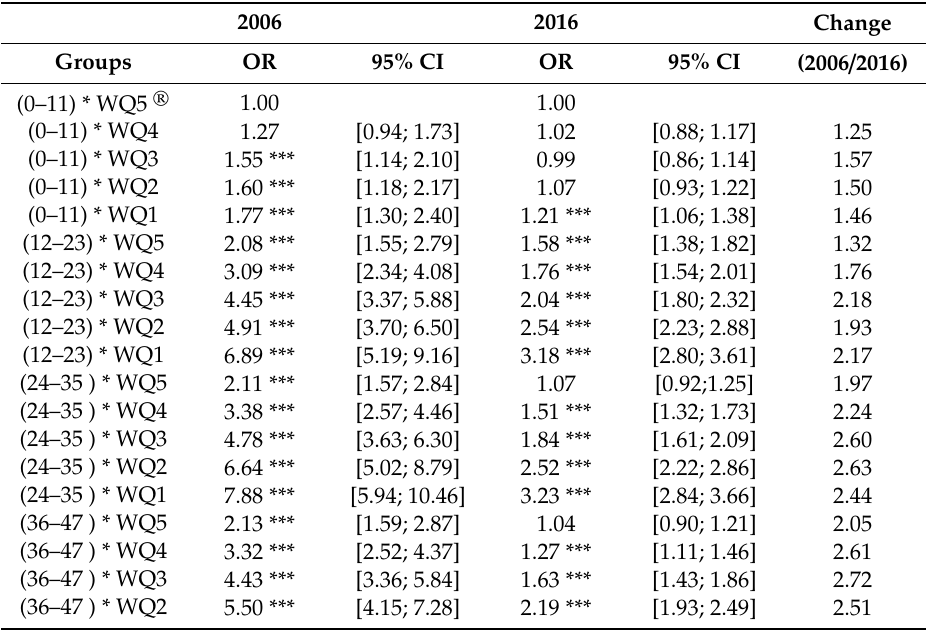
Table A5. Multilevel logistic regression-based odds ratio of severe stunting among children (below five years) across age groups (in months) and wealth quintiles, NFHS 2006, and